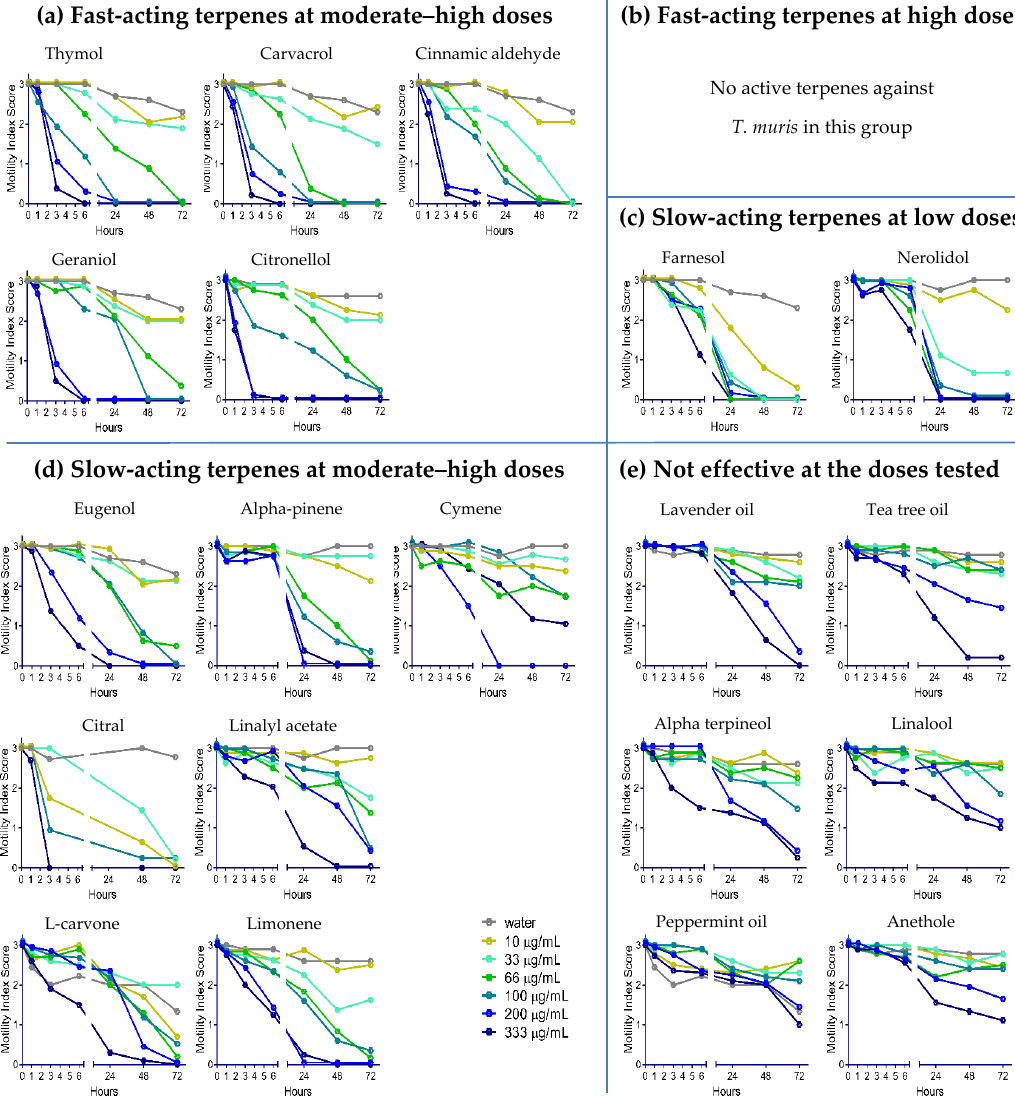
Figure 3. Dose–response of YP–terpenes on adult Trichuris muris in vitro, as shown for ( a ) fast-acting terpenes at moderate–high doses, ( b ) fast-acting terpenes at high doses, ( c ) slow-acting terpenes at lower doses, ( d ) slow-acting terpenes at moderate–high doses, and ( e) terpenes not effective at the doses tested. Terpenes were evaluated at concentrations from 0 to 333 µg/mL. Parasitic worms were scored at the times indicated for motility, where 3 is actively moving, 2 is slow moving, 1 is not moving unless touched, and 0 is not moving even when touched (likely dead). N = eight adult worms/condition.